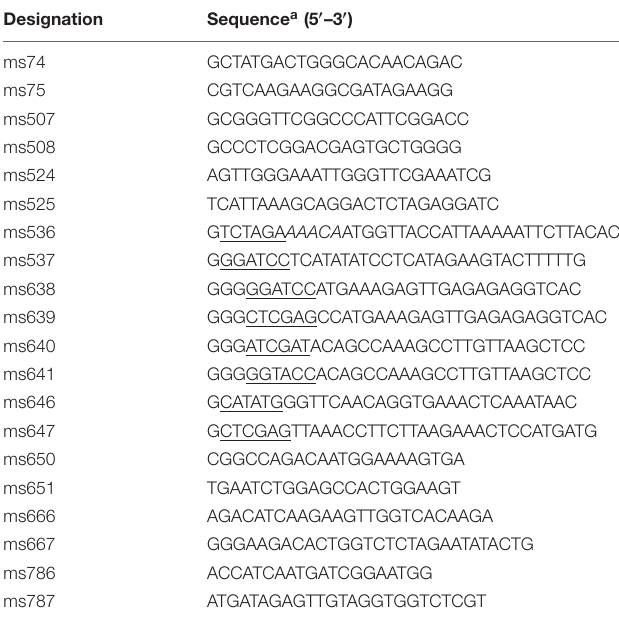
TABLE 1 | Oligo nucleotide primers used in this